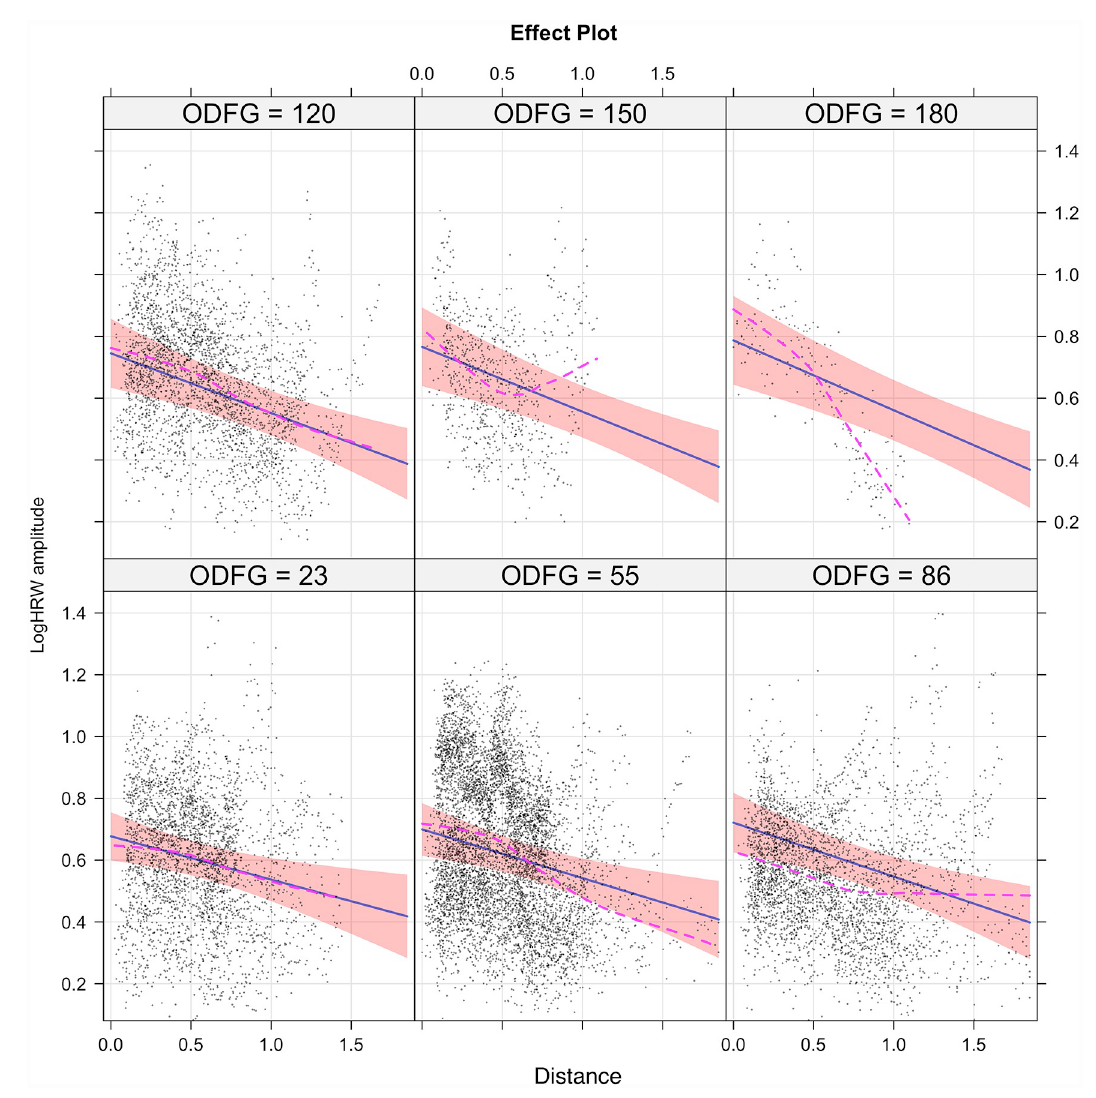
Fig 8. The interaction model of retinal arterial pulse log harmonic regression waveform amplitude (logHRW a ). There was a positive correlation between HRW a attenuation and increasing ODF characterized by steepening of the slope of the regression line from -0.14 at 23g force to -0.23 at 180g force with the maximal change in log HRW a occurring at the center of the optic disc. Demonstrated are the 95% confidence intervals for the slope of the regression line. The sequence commences from the lower left to the upper right. The dashed line is the loess smoothed regression curve, superposition of both the curve and the regression line indicated a favorable model